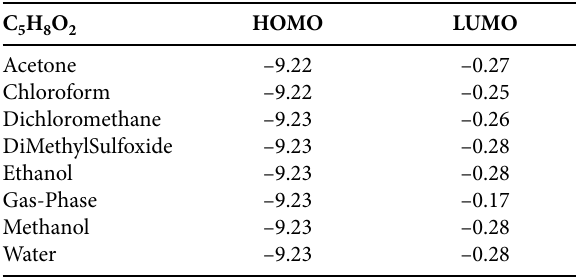
Table 6: PCM-CAM-B3LYP/6-311+G(d) results for the energy HOMO-LUMO (in eV) of compound C 5 H 8 O 2 in a solvent